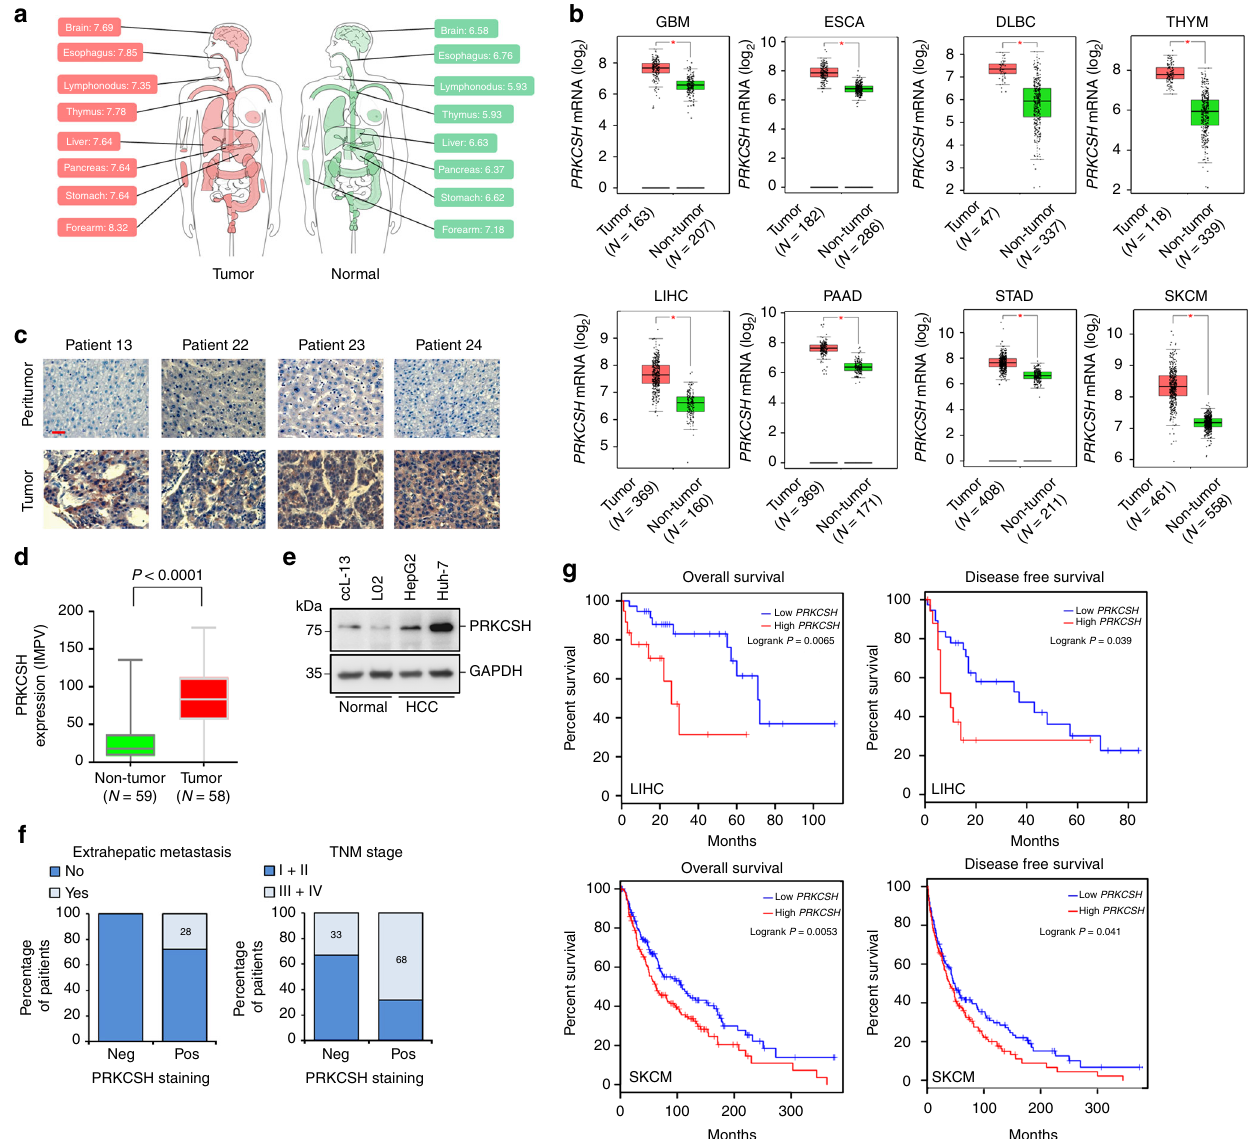
Fig. 1 The level of PRKCSH is increased in various cancer tissues. a Map of human organs in which the expression of PRKCSH mRNA is signi fi cantly higher in tumors than in nontumor. Gene-expression datasets from TCGA were analyzed by using the GEPIA web tool. b Scatter plots showing relative levels of PRKCSH mRNA in nontumor and tumor tissues. Median expression levels in each group are indicated by horizontal lines and these values are shown in ( a ). One-way ANOVA; * P < 0.01. c Representative immunohistochemical images, and d relative levels of PRKCSH protein. The intensity of PRKCSH staining in paraf fi n-embedded sections of liver tissue arrays (nontumor, n = 59; tumor, n = 58) was calculated as described in Supplementary Fig. 1c. Scale bars represent 20 µ m. The center line of the boxplots denotes the median, the bounds of the box indicate 25 – 75% and the whiskers represent 5 – 95%, respectively. Signi fi cance of the differences between the two categories was determined by the Student t test ( P < 0.0001). e Immunoblot analysis of PRKCSH expression in human liver cell lines. f Relationship between PRKCSH expression and clinicopathological features. Among the clinicopathological data of the liver tissue array, extrahepatic metastasis and TNM stage were positively related to PRKCSH staining (Supplementary Table 1). g Overall survival and disease-free survival curves for patient groups with high and low PRKCSH expression level. The data were obtained from TCGA datasets. Signi fi cance of the differences between the two categories was determined by Log-rank